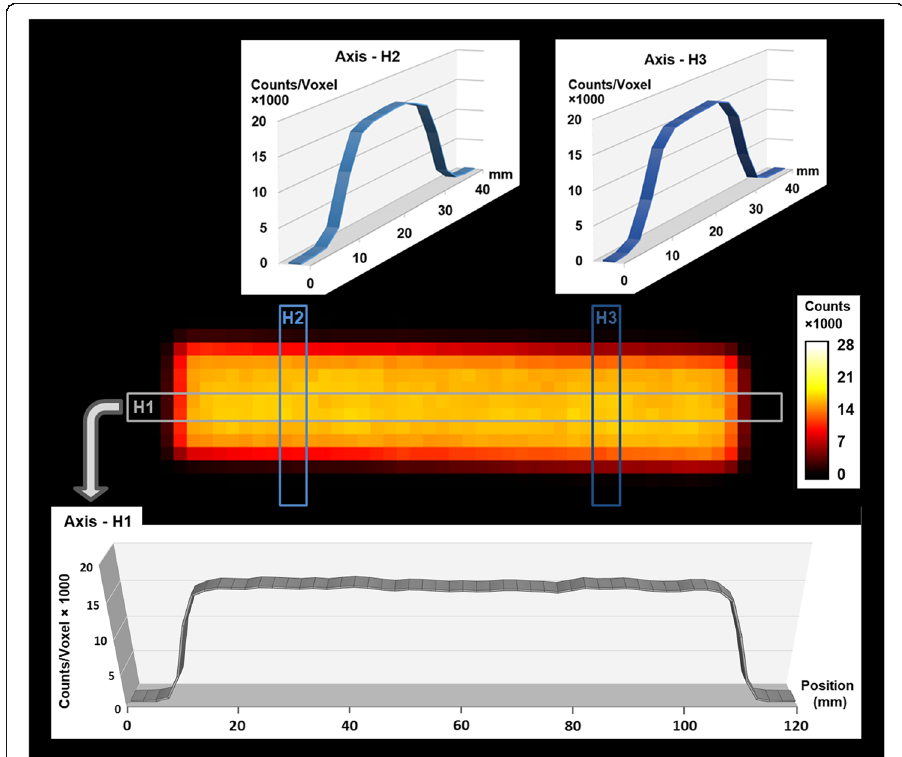
Fig. 3 Radioactivity distribution profiles in different directions across the bar-shaped phantom as determined on a γ -camera